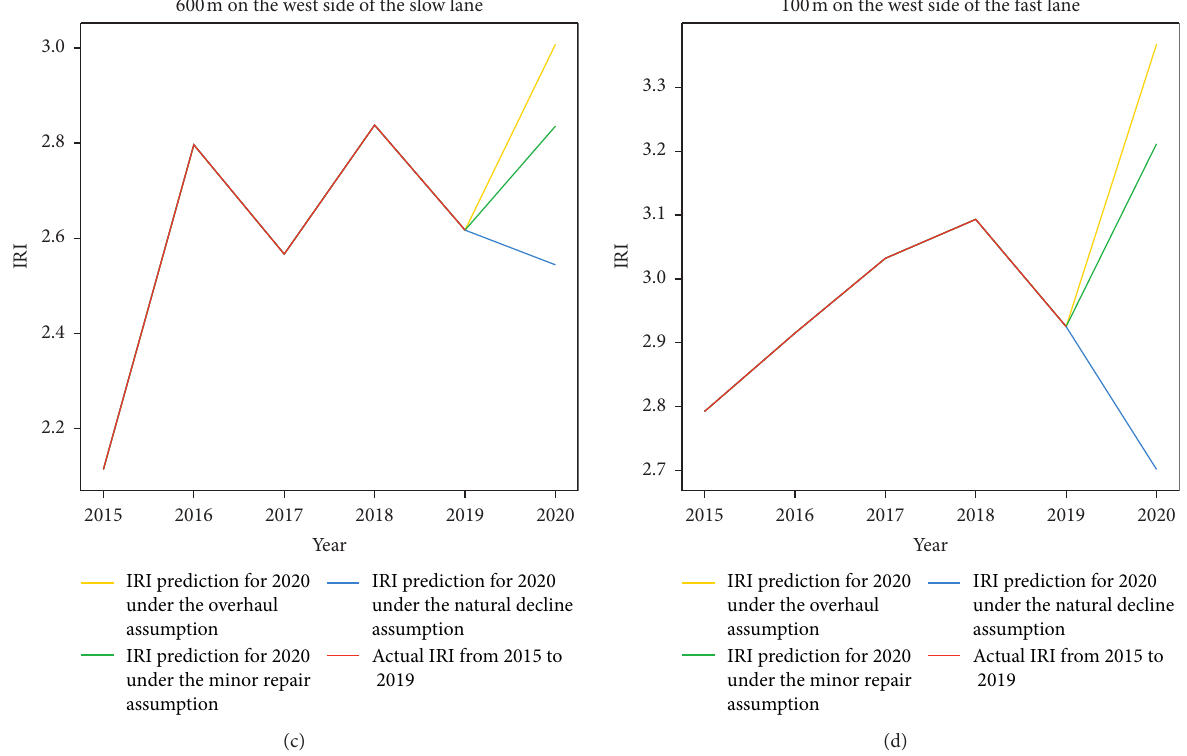
Figure 14: Trend chart of some segments of the pavement performance of the Dalian highway in 2020. (a) 1100m on the east side of the slow lane. (b) 1100m on the east side of the fast lane. (c) 600m on the west side of the slow lane. (d) 600m on the west side of the fast